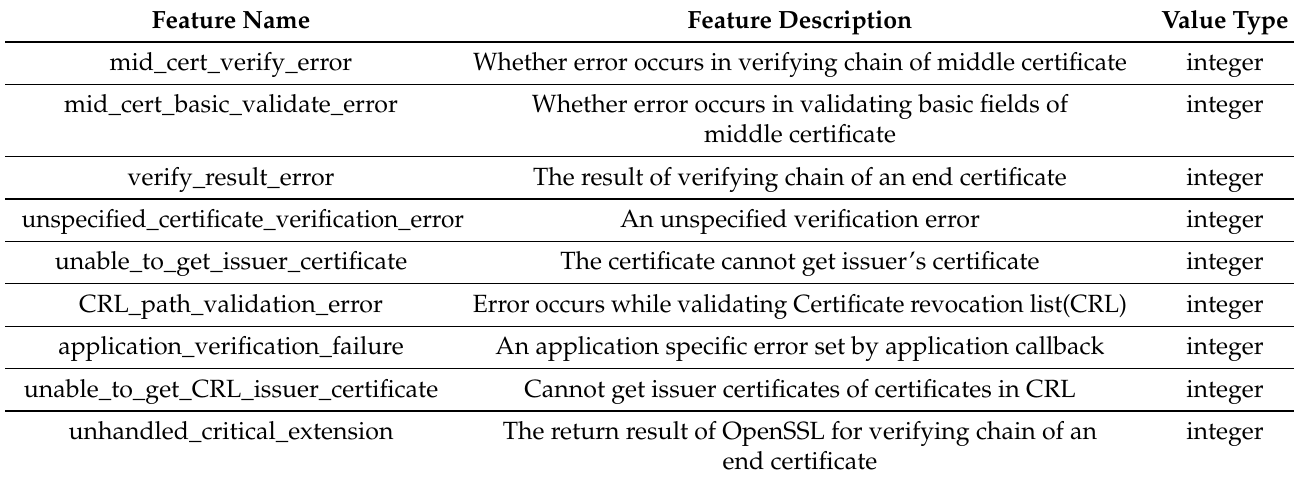
Table 7. Sample features from certificate chain validation.